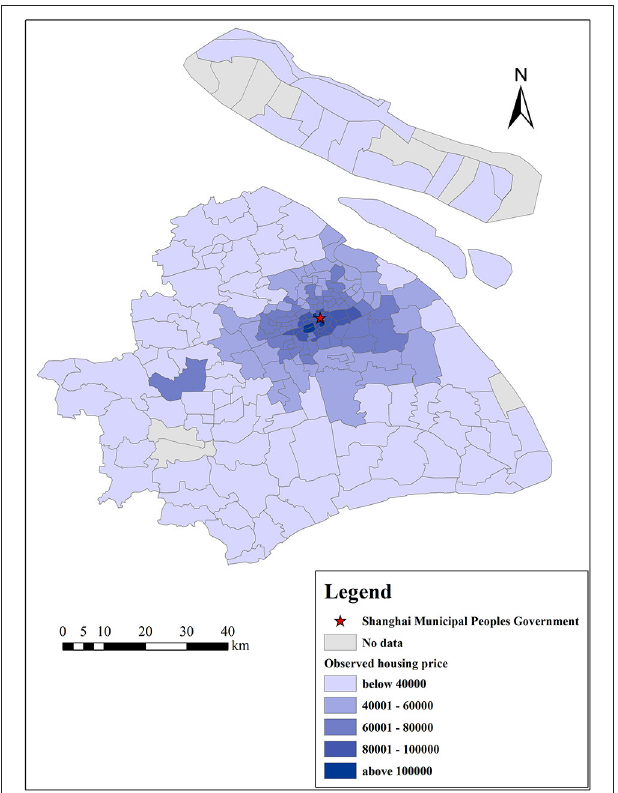
FIGURE 8 | Observed housing prices (Yuan/m 2 ) in Shanghai.